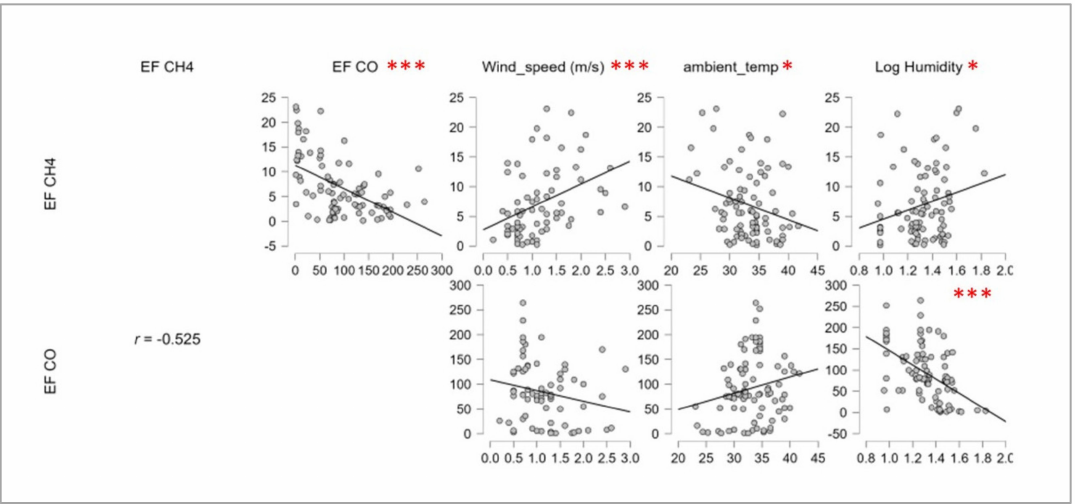
Figure 12. Correlation Plots for Methane and Carbon Dioxide EF and Ambient Weather (*** p < 0.001, ** p < 0.01, * p < 0.05).